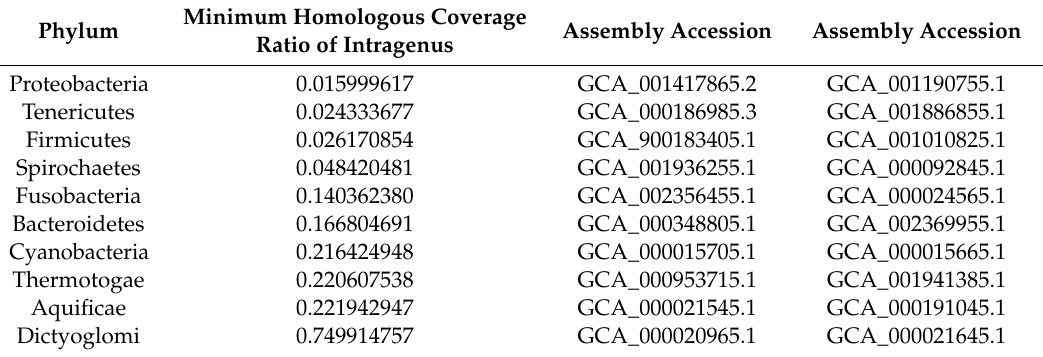
Figure 1. Multidimensional scaling ordination plot based on homologous distances among microorganisms. Genome-wide sequences of 7861 microbial strains were downloaded from the National Center for Biotechnology Information’s RefSeq, including 940 bacterial genera, 91 Archaea, and 17 fungal strains. Multidimensional scaling was drawn with homology between strains. Different colors represent different phyla. Table 1. Top 10 pairs of assembly accessions with minimum intraphylum homologous coverage ratio.